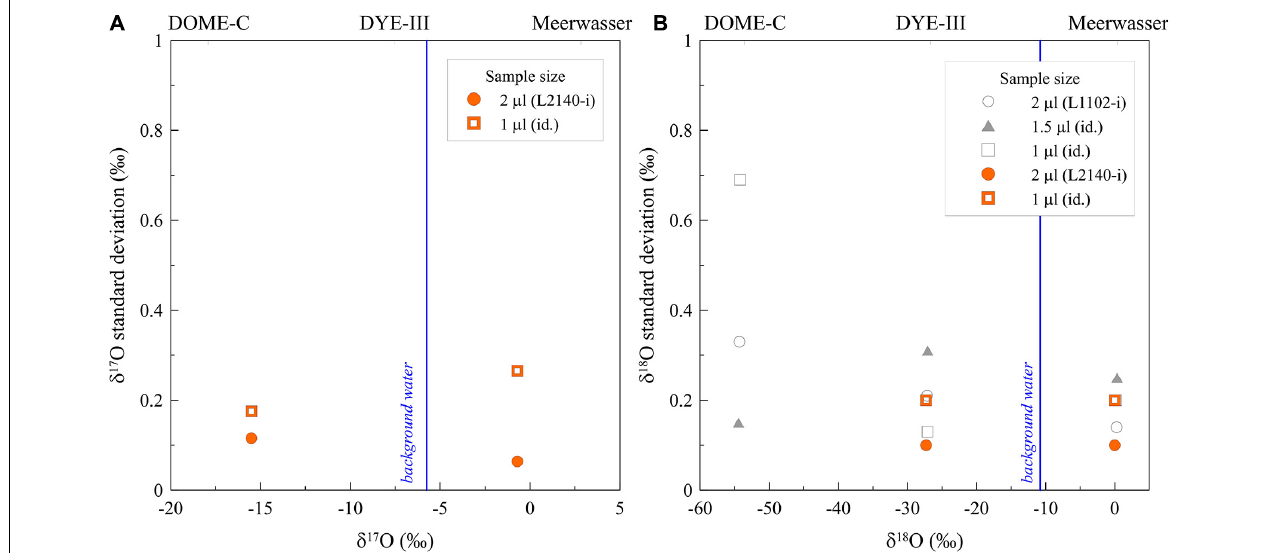
FIGURE 3 | Comparison of the fluid inclusion line performance between the laser spectrometers L2140- i (orange symbols, this study) and L1102- i (gray symbols; Affolter et al., 2014). We injected standard waters of 1 and 2 µ l with a syringe for δ 17 O (A) and δ 18 O (B) measurements.